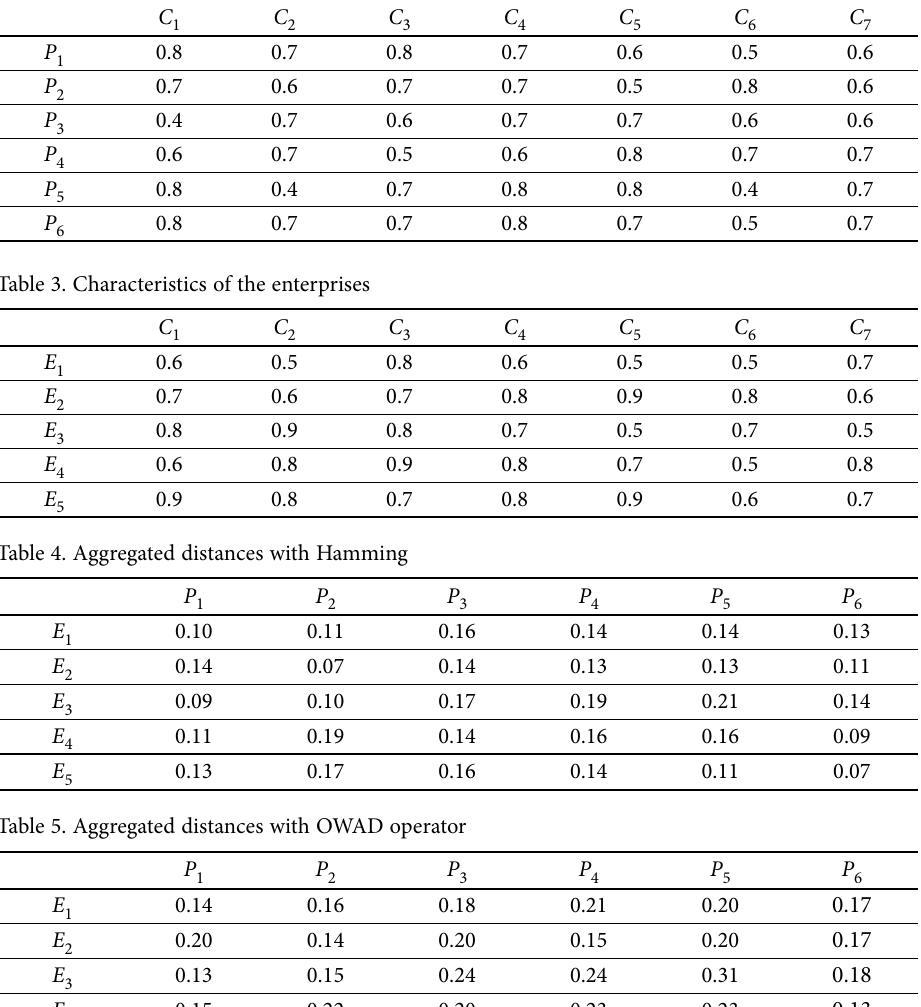
Table 2. Characteristics of the financial products